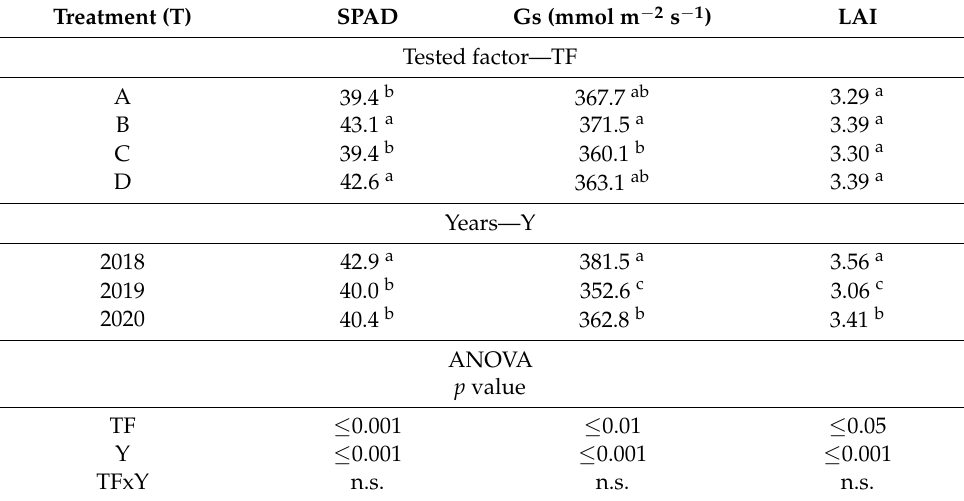
Table 3. Field measurements of leaves and